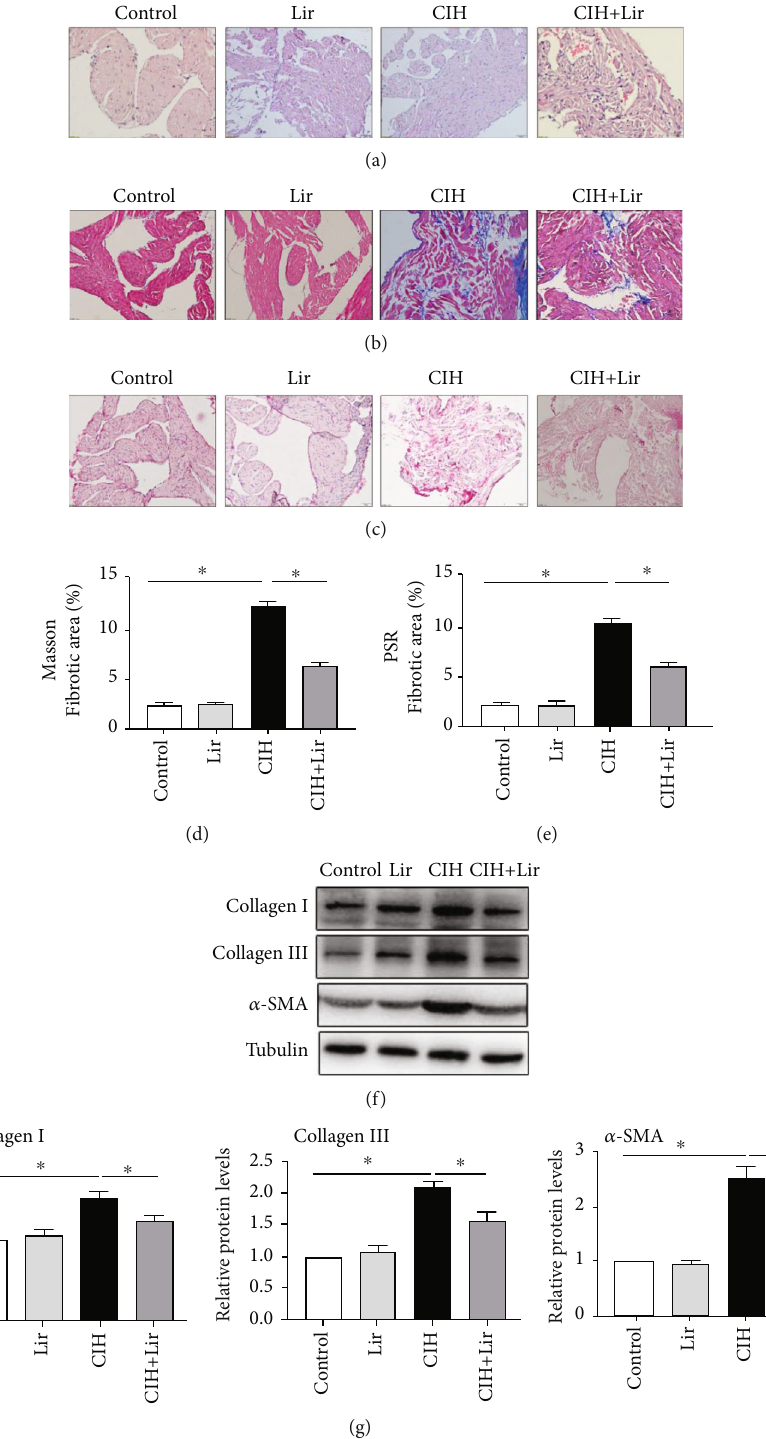
Figure 4: The e ff ect of Lir on CIH-induced atrial fi brosis. (a – c) Representative images of HE, Masson, and Sirius red staining of atrial tissue in four groups. Interstitial fi brosis in the atrial tissue increased in the CIH group compared to the control group and reduced signi fi cantly in the CIH+Lir group. (d, e) Quanti fi cation of fi brotic area of Masson and Sirius red staining in four groups ( n = 6 ). (f, g) Western blot analysis of the expression of collagen I, collagen III, and ɑ -SMA in the atrial. The expression of these proteins is increased in the CIH group compared to the control group and reduced in the CIH+Lir group ( n = 6 ). Data are mean ± SEM , ∗ P < 0 : 05